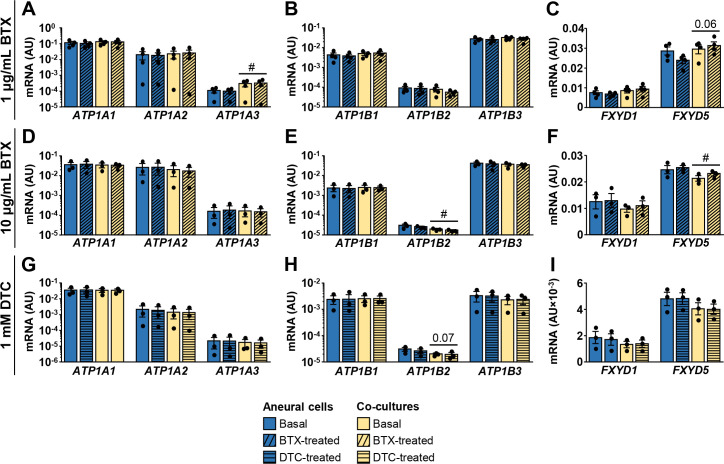
Effect of α-bungarotoxin and tubocurarine on expression of NKA subunits, FXYD1, and FXYD5.21-day old co-cultures and aneural controls were treated with 1 μg/mL α-bungarotoxin (BTX) (A-C), 10 μg/mL α-bungarotoxin (D-F) or 1 mM d-tubocurarine (DTC) (G-I) for 24 h. (A-I) qPCR was used to estimate gene expression (geometric mean of ACTB and PPIA was used for normalization of results) of (A,D,G) NKAα1–3 (ATP1A1-3), (B,E,H) NKAβ1–3 (ATP1B1-3), or (C,F,I) FXYD1 and FXYD5. Human-specific gene expression assays were used. Results are means ± SEM (n = 3–4), #P<0.05 –aneural cells vs. co-cultures. Basal aneural cell and co-culture samples for 10 μg/mL α-bungarotoxin and 1 mM d-tubocurarine are the same, but were measured on separate occasions.